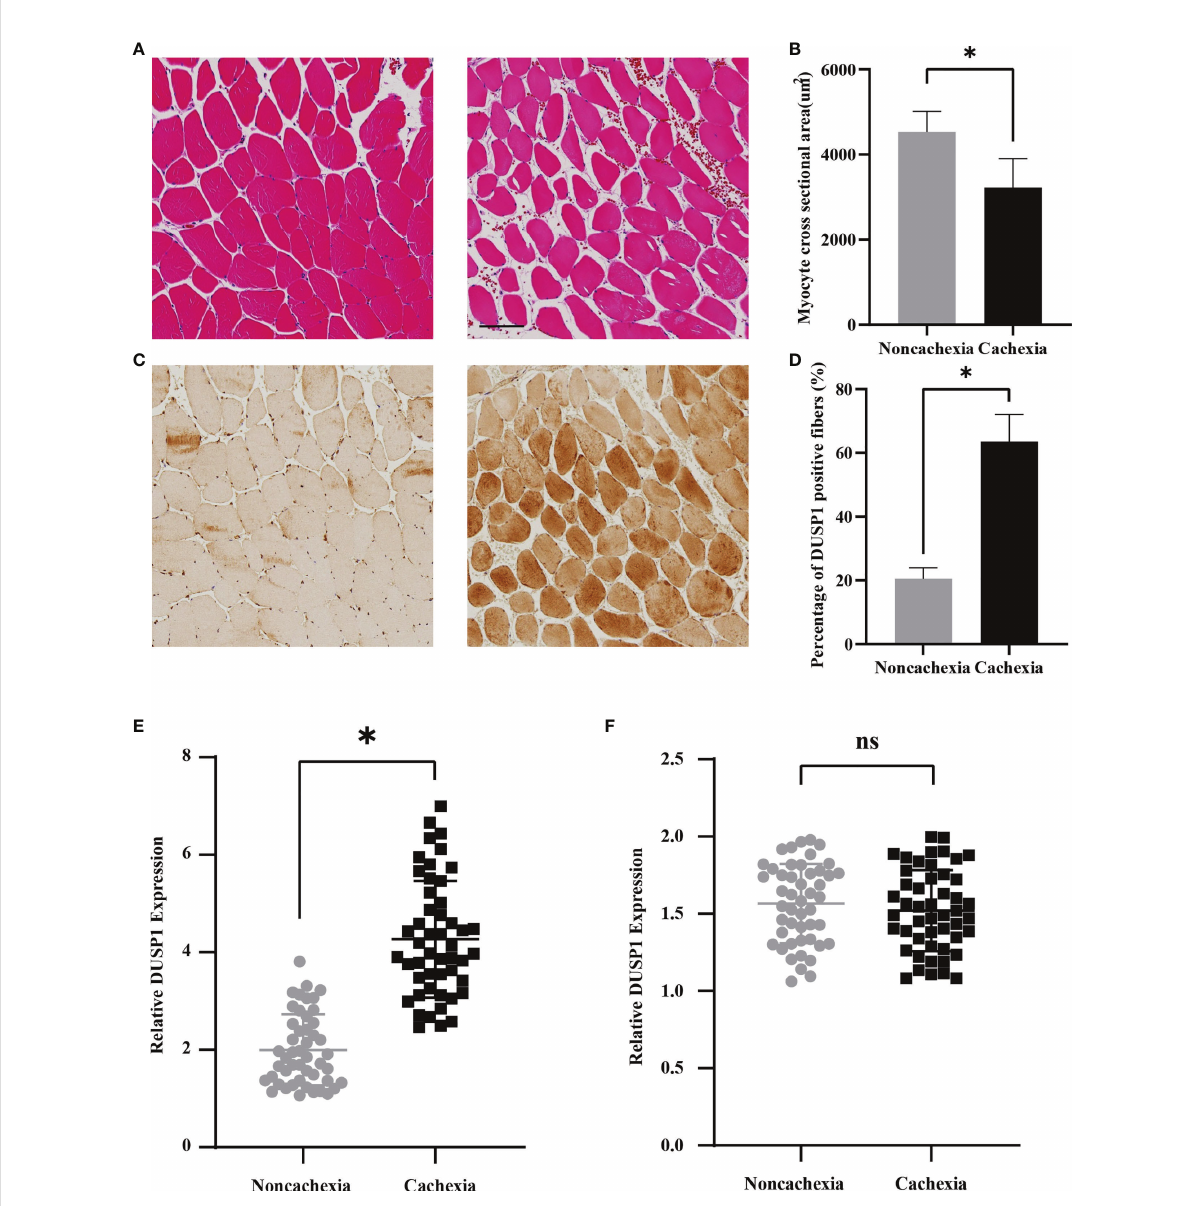
FIGURE 4 Expression of DUSP1 was associated with pathological process in cancer cachexia. (A) Morphological evaluation of skeletal muscle between cachectic and non-cachectic patients (hematoxylin – eosin) (Scale bar=100um). (B) Myocyte cross sectional area evaluation between cachectic and non-cachectic patients. (C) Representative images of IHC revealing DUSP1 expression between cachectic and non-cachectic patients. (D) Percentage of DUSP1 positive fi bers in skeletal muscle between cachectic and non-cachectic patients. (E) Expression of DUSP1 in muscle tissues between cachectic and non- cachectic patients. (F) Expression of DUSP1 in tumor tissues between cachectic and non-cachectic patients. *p < 0.05; ns, not signi fi